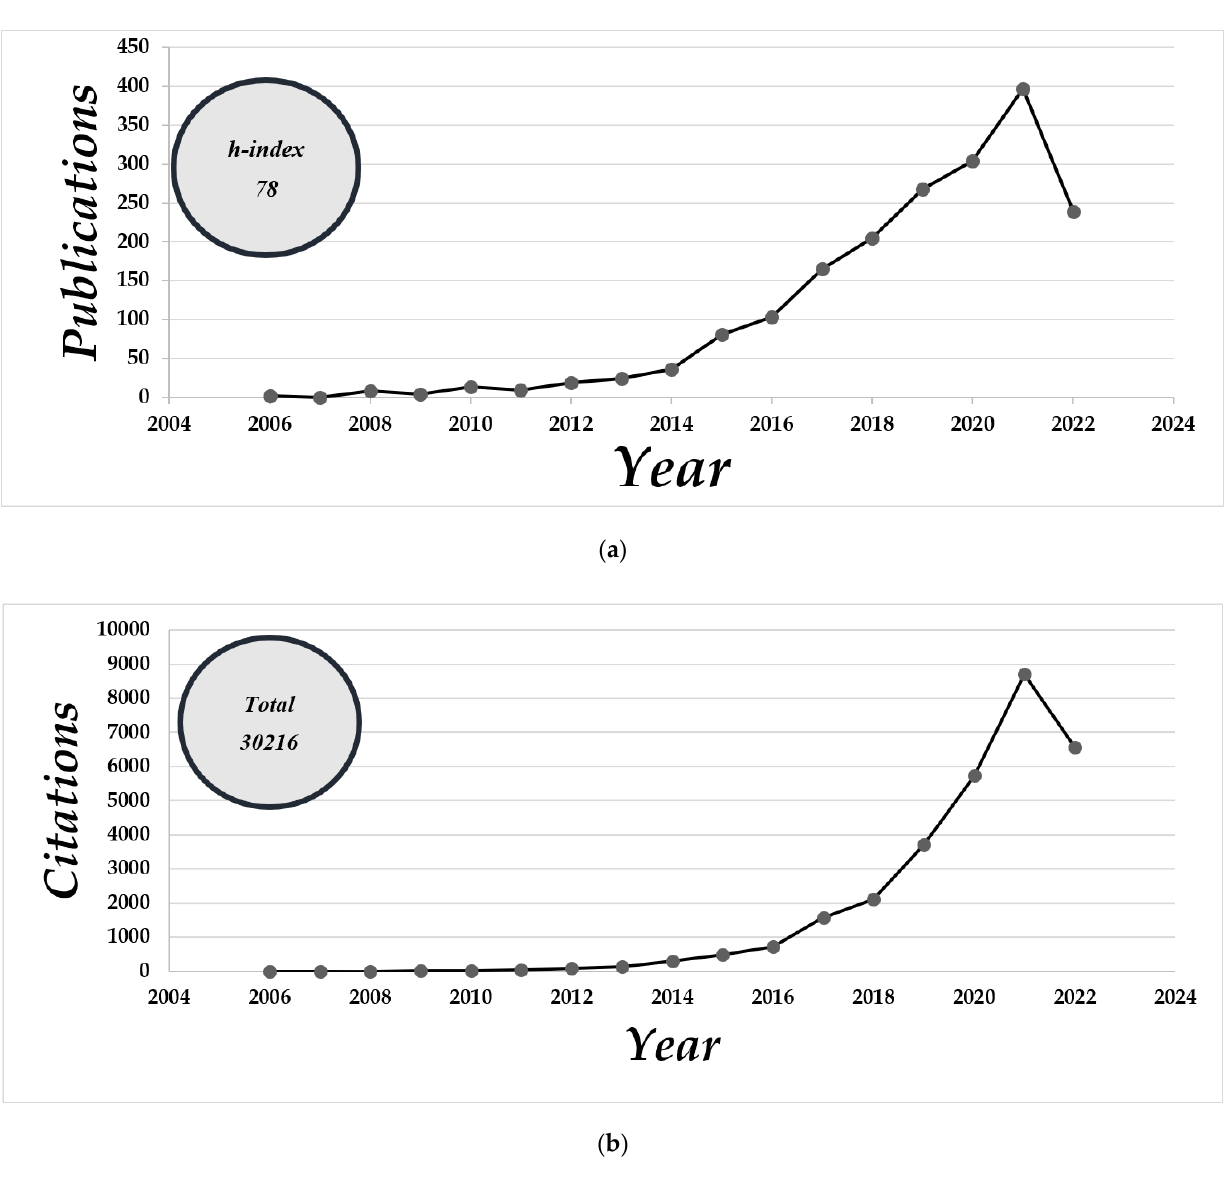
Figure 4. ( a ) Number of publications from 2006 to 2022; ( b ) Number of citations from 2006 to